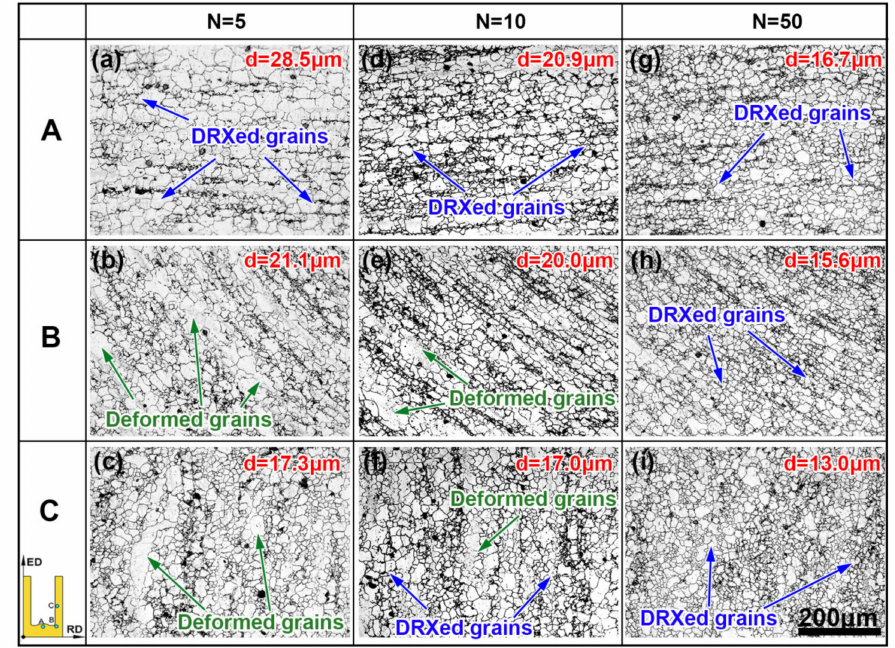
Figure 3. The OM maps of the RBE samples at the three di ff erent locations: ( a – c ) n = 5, ( d – f ) n = 10, and ( g – i ) n = 50.